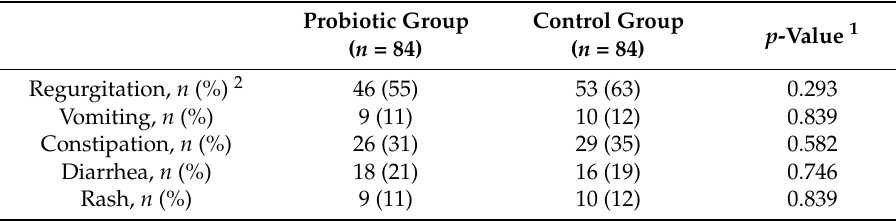
Table 2. Any gastrointestinal events or skin rashes before study